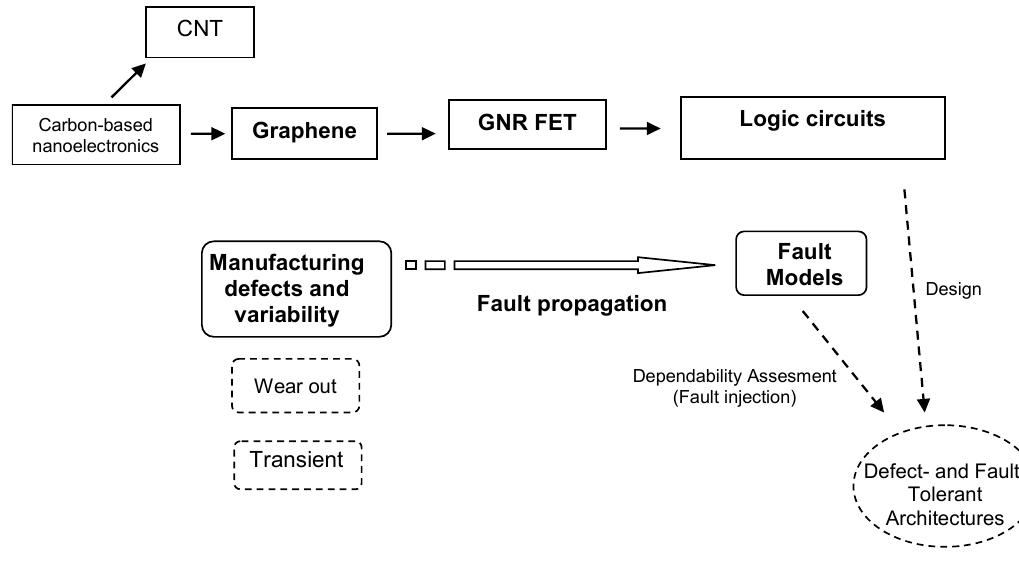
Figure 1. Planned methodology in our work.